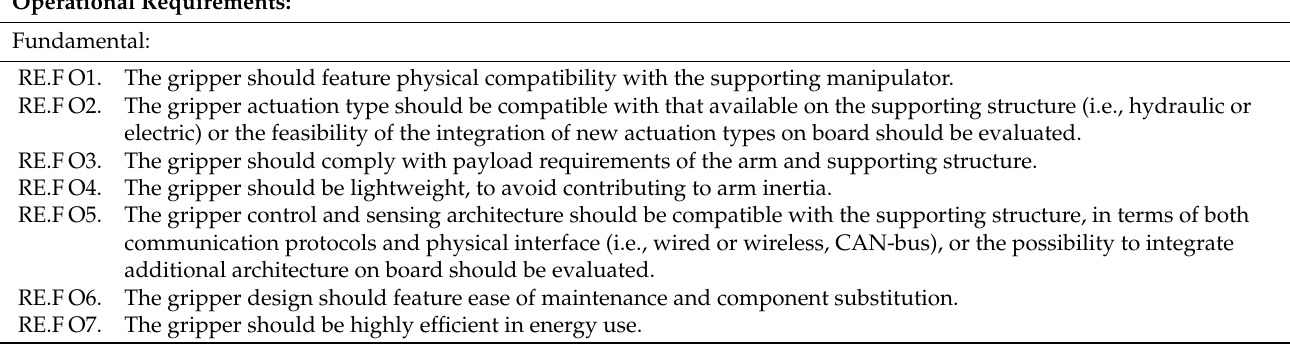
Table 6. Operational